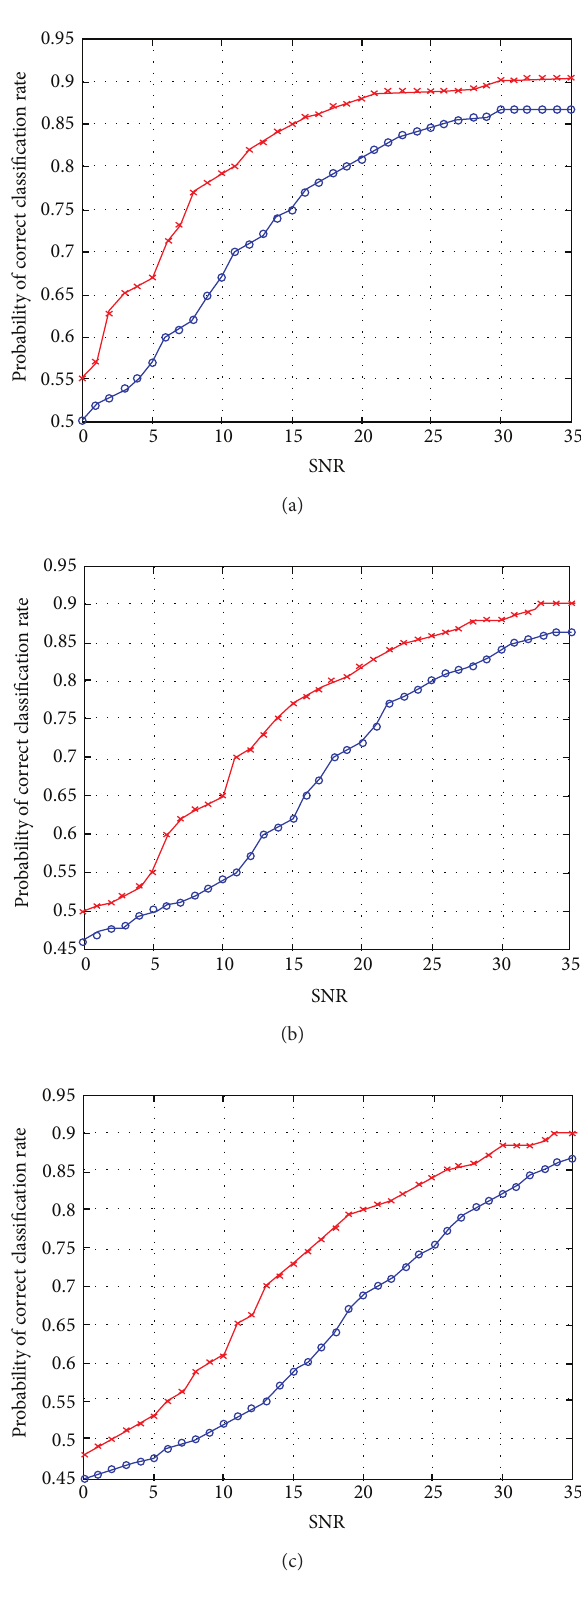
Figure 8: Probability of correct classification in Rayleigh fading channel versus SNR (a) 𝑓 𝐷 = 0 Hz, (b) 𝑓 𝐷 = 10 Hz, and (c) 𝑓 𝐷 = 100 Hz; ∗ SVM and ∘